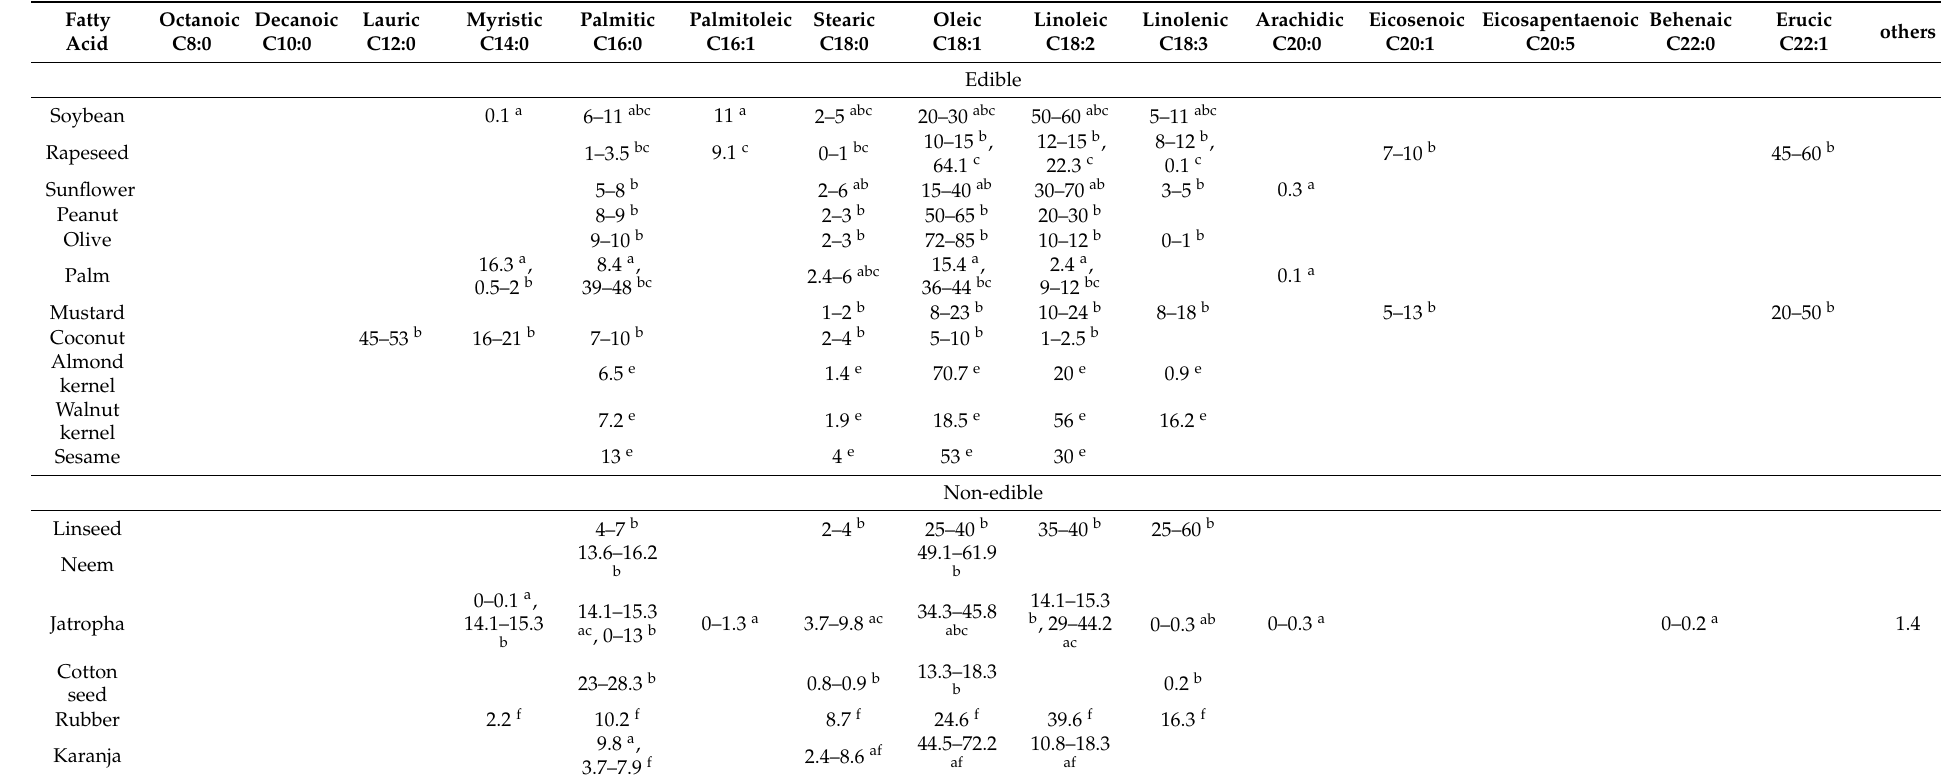
Table 4. Fatty acid composition (%) of different biodiesel